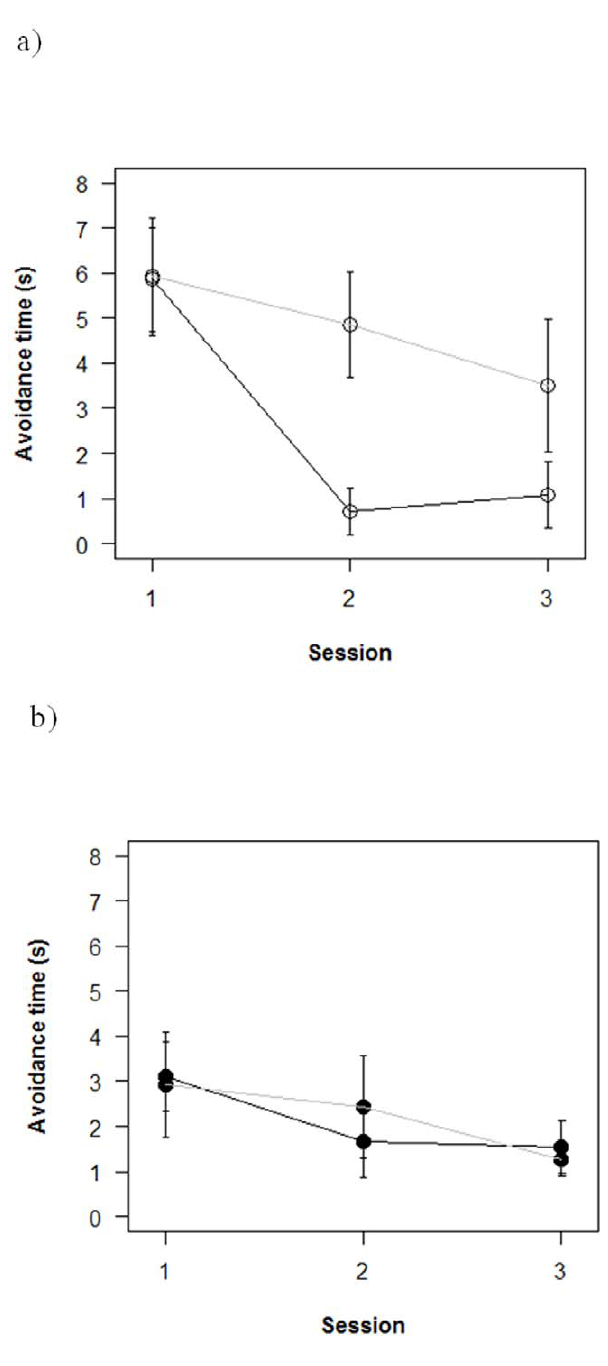
Figure 4. Sex effect of experienced fish (key and non-key) differs according to genetic background. 4a) Groups with experienced females avoided the aversive stimulus slowly at the first session, but improved performance more quickly when the experienced female was a Key fish (black line) as opposed to a non-Key fish (gray line). 4b) Groups with experienced males avoided quickly from the first trial, and showed little change in performance across the three sessions leading to a significant interaction effect. Error bars are one standard error. Data are for the same trials as in Fig. 3, but combining data from PN and SH